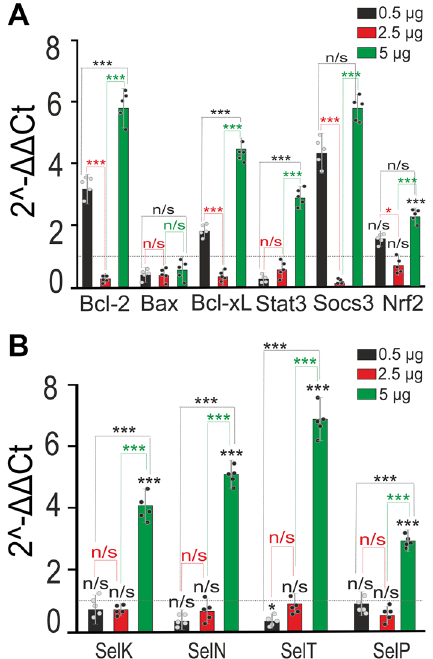
Figure 4. Effect of SeNPs on the basal expression of genes, encoding pro-apoptotic proteins and selenoproteins. ( A, B ) Effect of 24-h incubation of cortical cells with 0.5 and 5 µg/ml SeNPs on basal expression of genes involved in regulation of apoptosis ( A ) and coding of selenoproteins ( B ). The number of samples is 5 (5 cell cultures). Dashed line level of gene expression in controls (without SeNPs). Statistical significance was assessed using one-way ANOVA followed by the Tukey–Kramer test. n/s—data not significant ( p > 0.05), * P < 0.05, ** P < 0.01, and *** P <